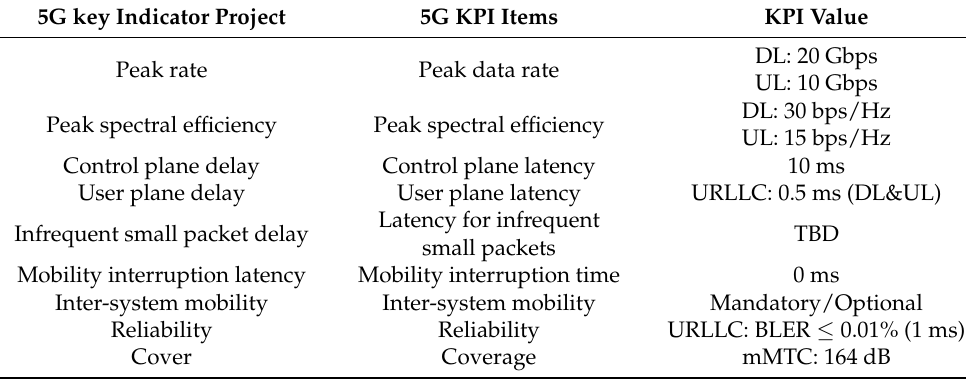
Table 2. Fifth generation (5G) New radio interface KPI